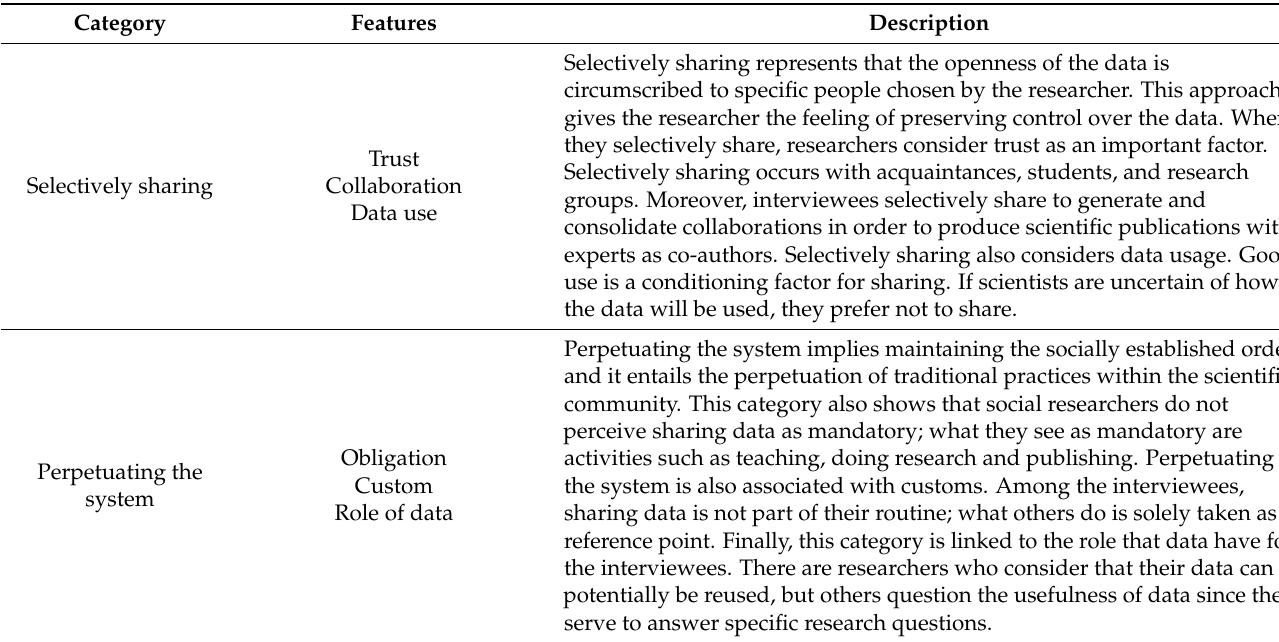
Table 1. Overview of social scientists’ interest in sharing research data.